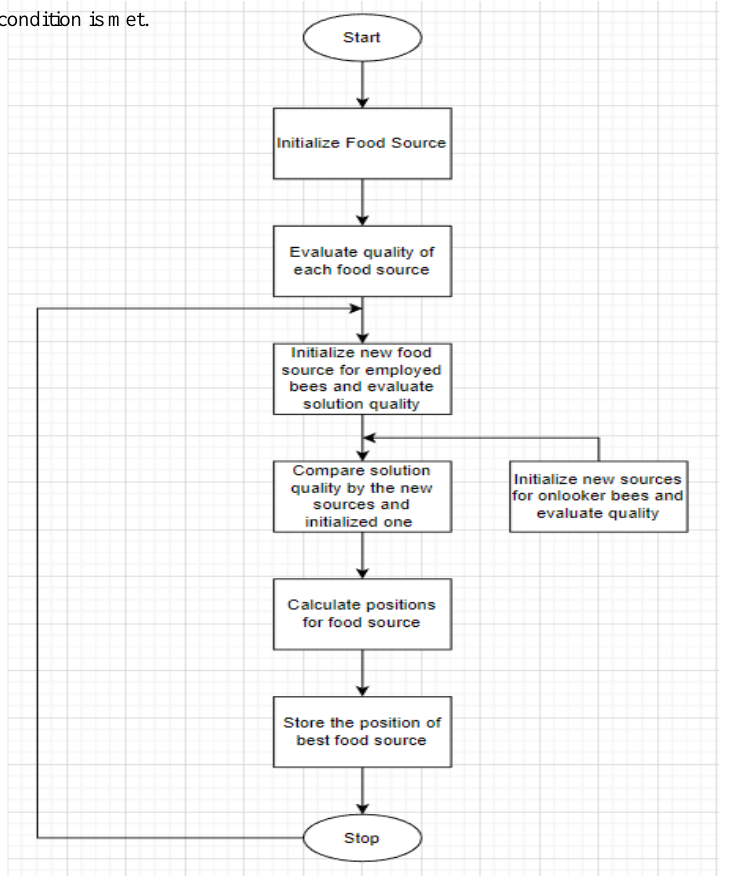
Figure 1: Visual Representation of the Steps Involved in the Abc Algorithm :( Metha,